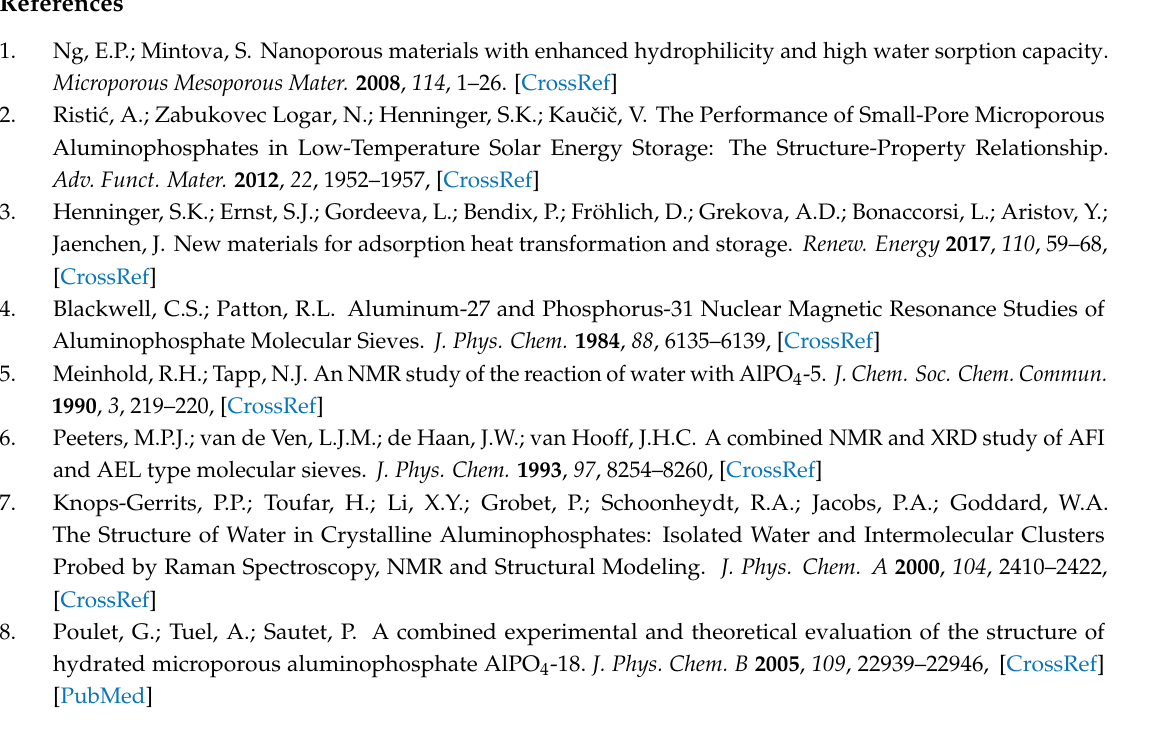
Supplementary Materials: The supplementary materials are available online. Table S1: Table of individual T-O distances, Table S2 and Figure S1: Structural parameters of partially hydrated phases, Tables S3 and S4, Figures S2 and S3: Displacement parameters, Figures S4 to S8: Radial distribution functions; other material: CIF files of DFT-optimised AlPO 4 -H3 and AlPO 4 -C; CASTEP *.phonon files of AlPO 4 -H3 and AlPO 4